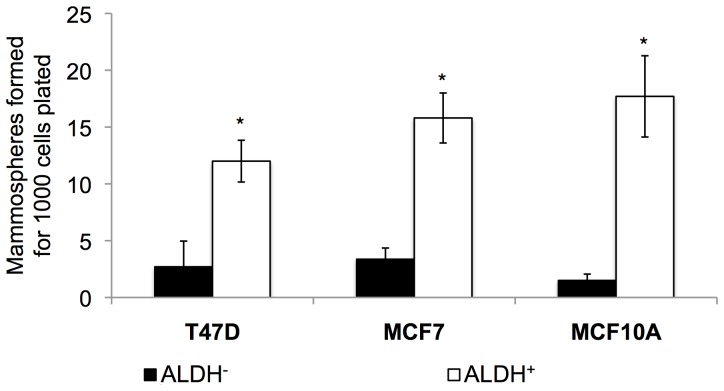
Mammosphere-forming ability of ALDH− cells and ALDH+ CSCs.Sorted ALDH− and ALDH+ T47D, MCF7 and MCF10A cells were plated in ultra-low adherence plates and the number of mammospheres formed after 7 days was counted. Error bars represent standard deviation. Results are representative of three independent experiments. Error bars represent standard deviation. Asterisks denote significant differences (t-test, *p<0.05, **p<0.01).